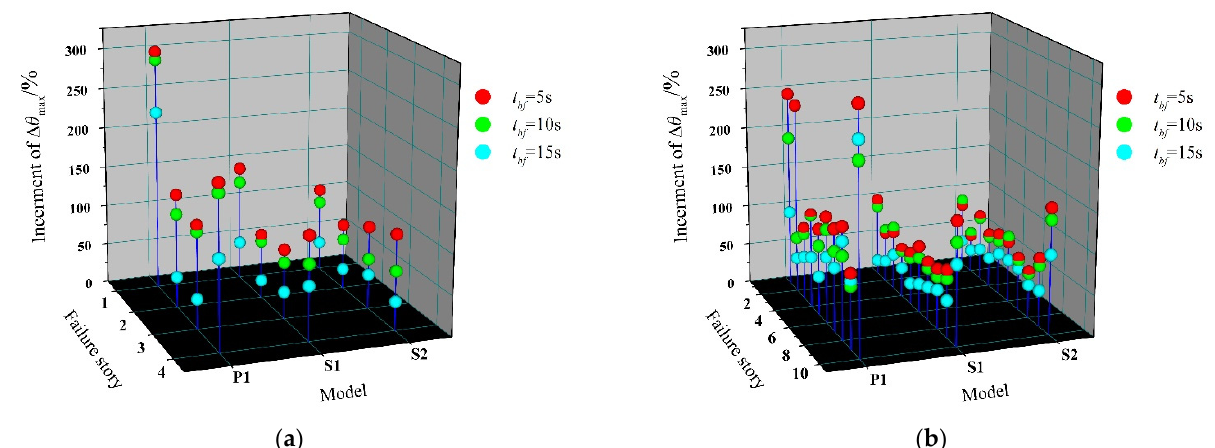
Figure 16. Increment of Δ θ max in failure story: ( a ) 4-story; ( b ) 10-story.